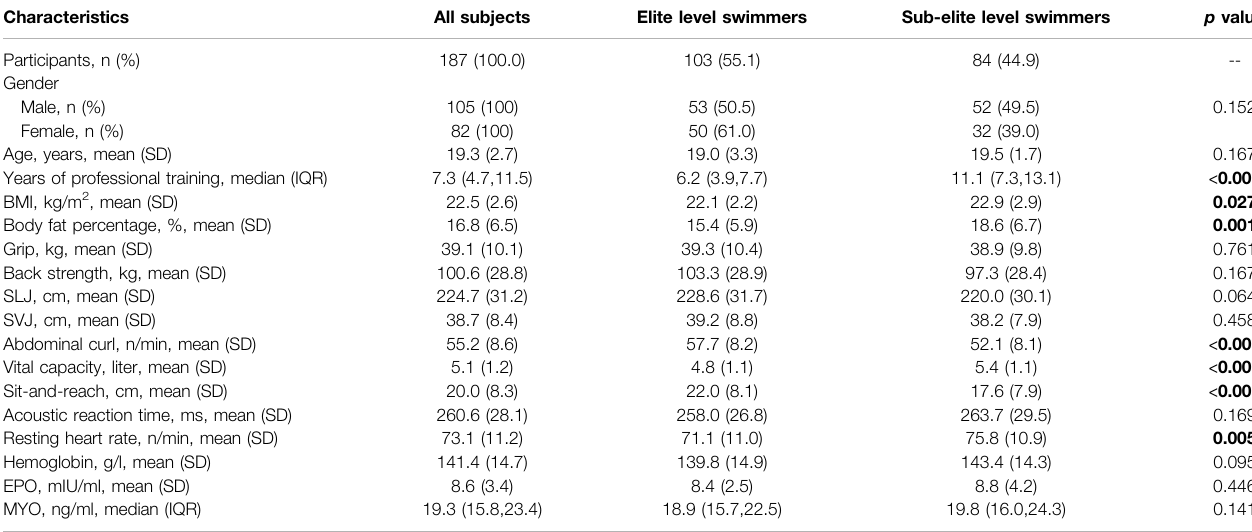
TABLE 1 | Baseline, physical performance and health characteristics of swimmers. Characteristics All